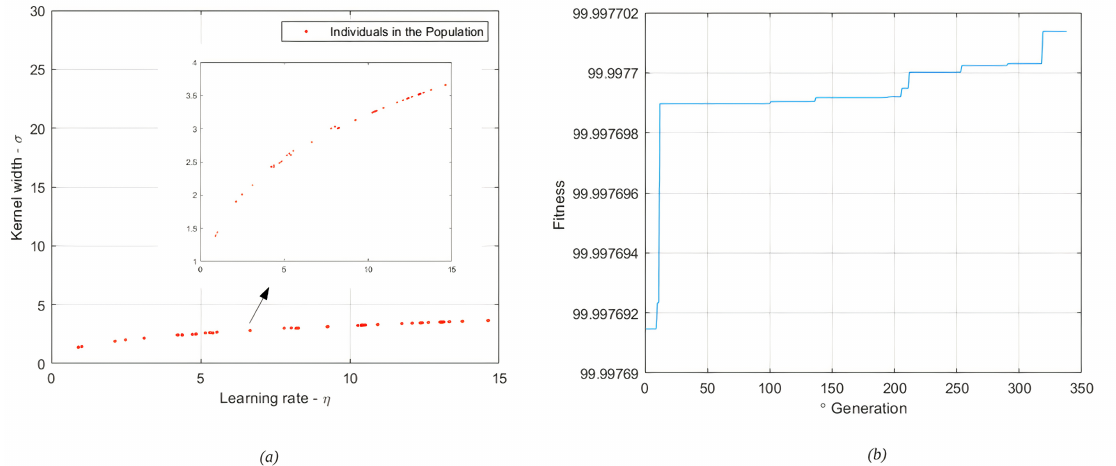
Figure 6. Population of individuals ( a ), Fitness of Generations ( b ). State of Charge—individuals of the population for training without the presence of noise and outliers—350 ◦